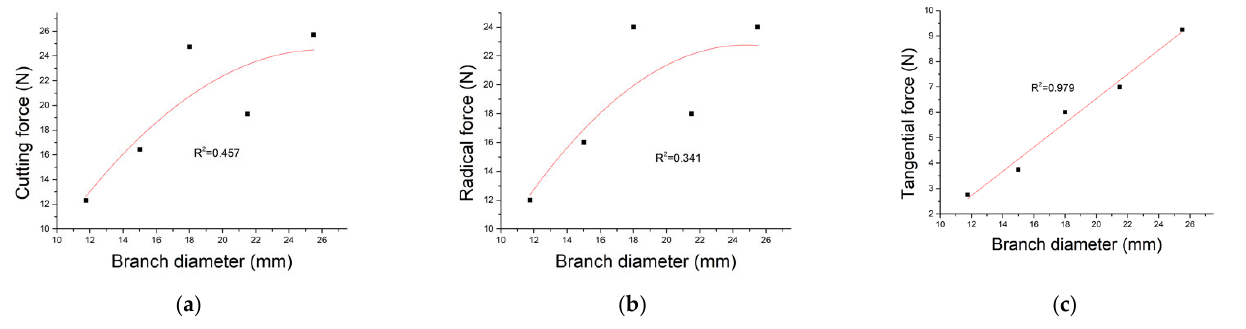
Figure 5. ( a ) Effect of branch diameter on cutting force; ( b ) effect of branch diameter on radical force; ( c ) effect of branch diameter on tangential force.